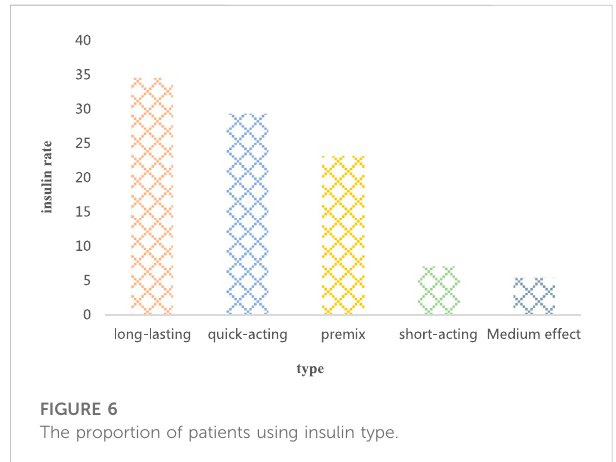
FIGURE 6 The proportion of patients using insulin type.